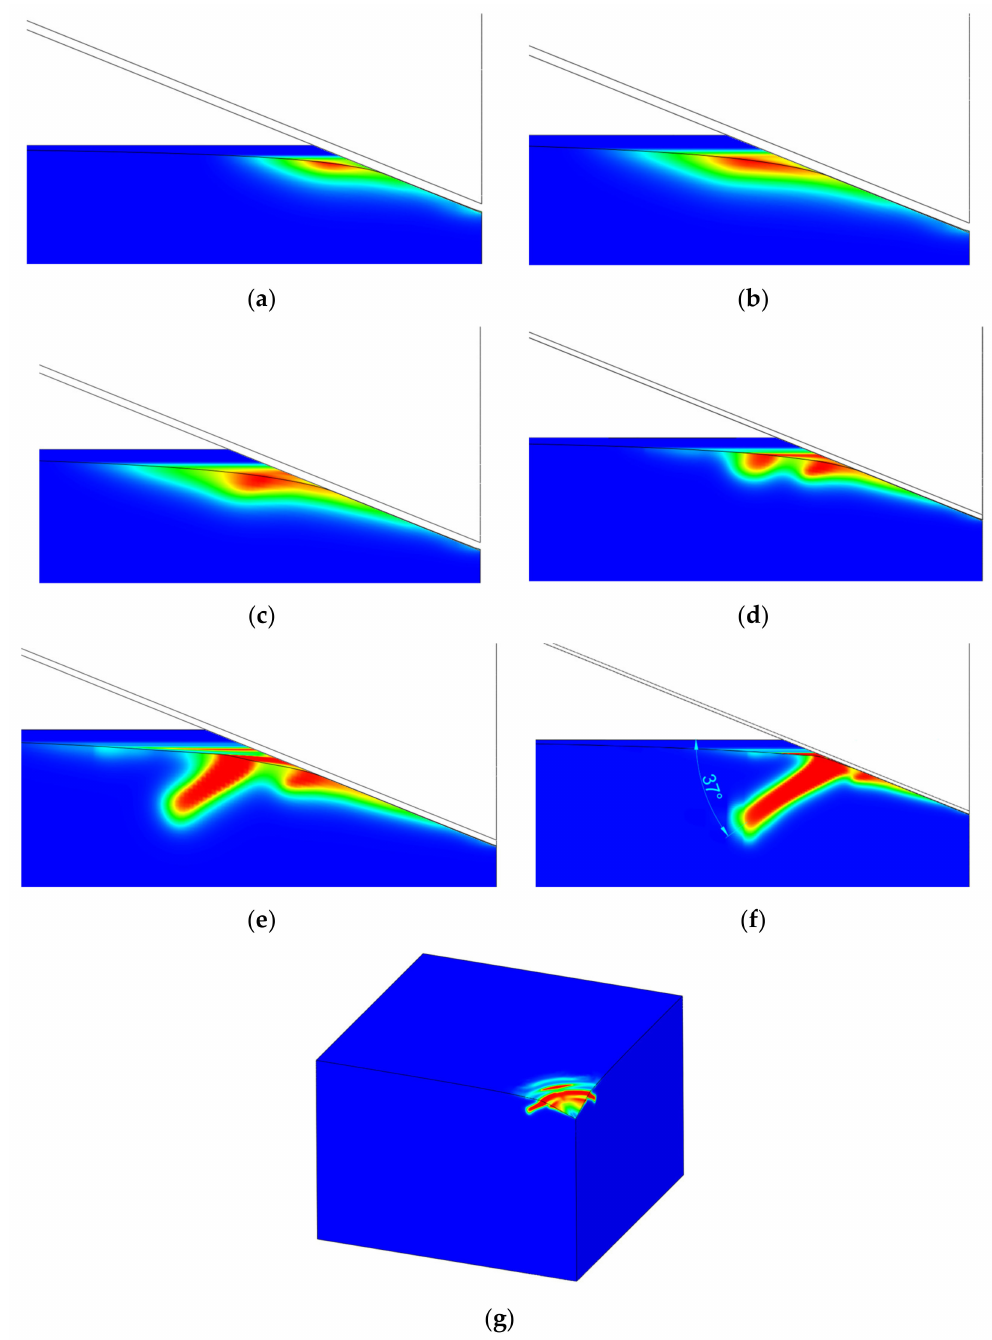
Figure 8. Stable crack growth with inclination angle at different penetration depths: ( a ) u = 1.2 µ m, ( b ) u = 1.65 µ m, ( c ) u = 2.025 µ m, ( d ) u = 2.4 µ m, ( e ) u = 2.8 µ m, ( f ) u = 3.375 µ m, front view for different penetration depths, and ( g ) isometric view without indenter at u = 3.375 µ m (max.